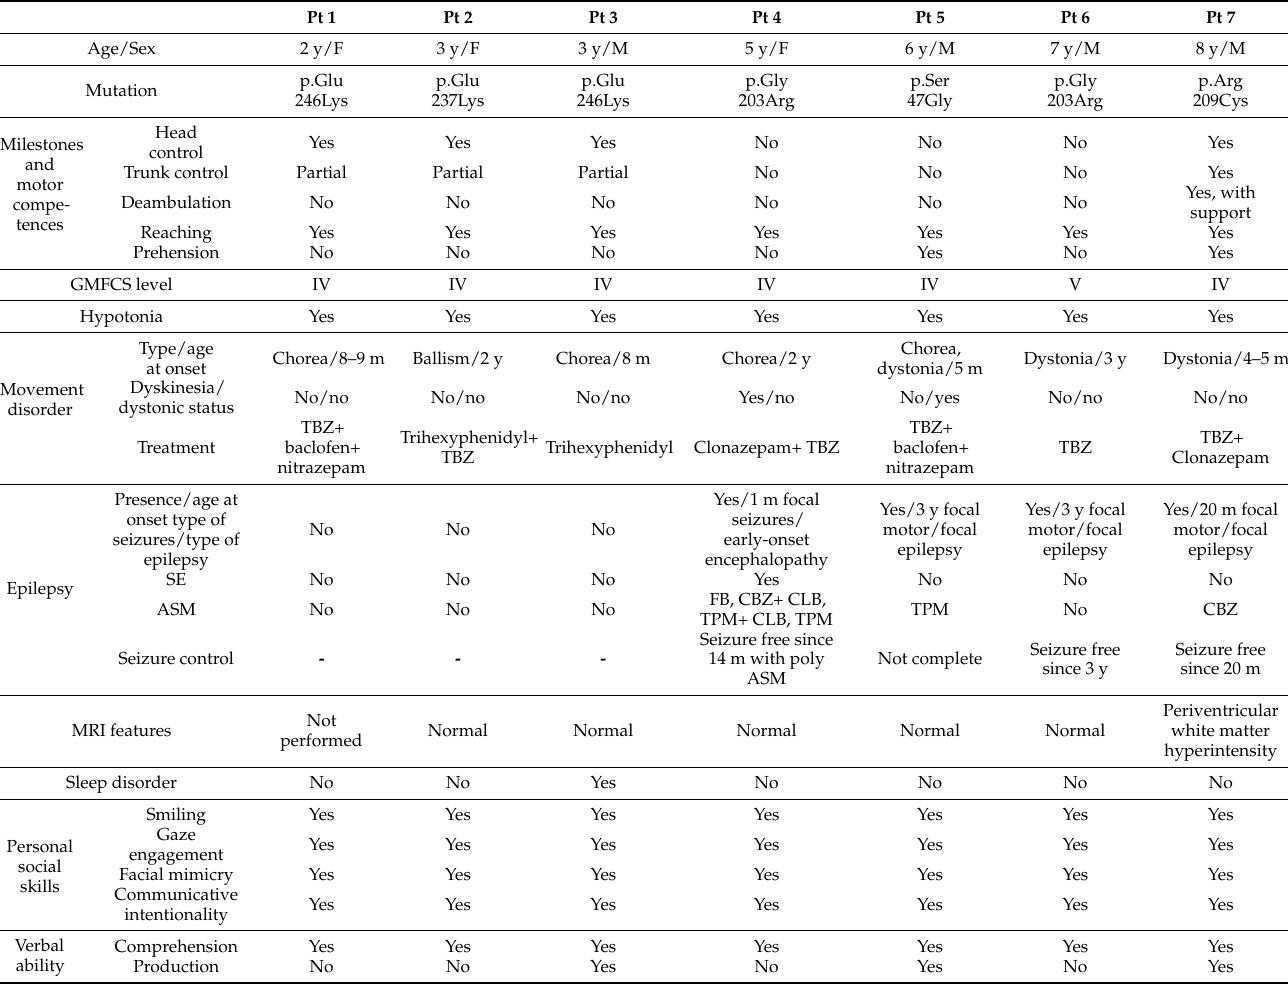
Table 1. Neurological data.